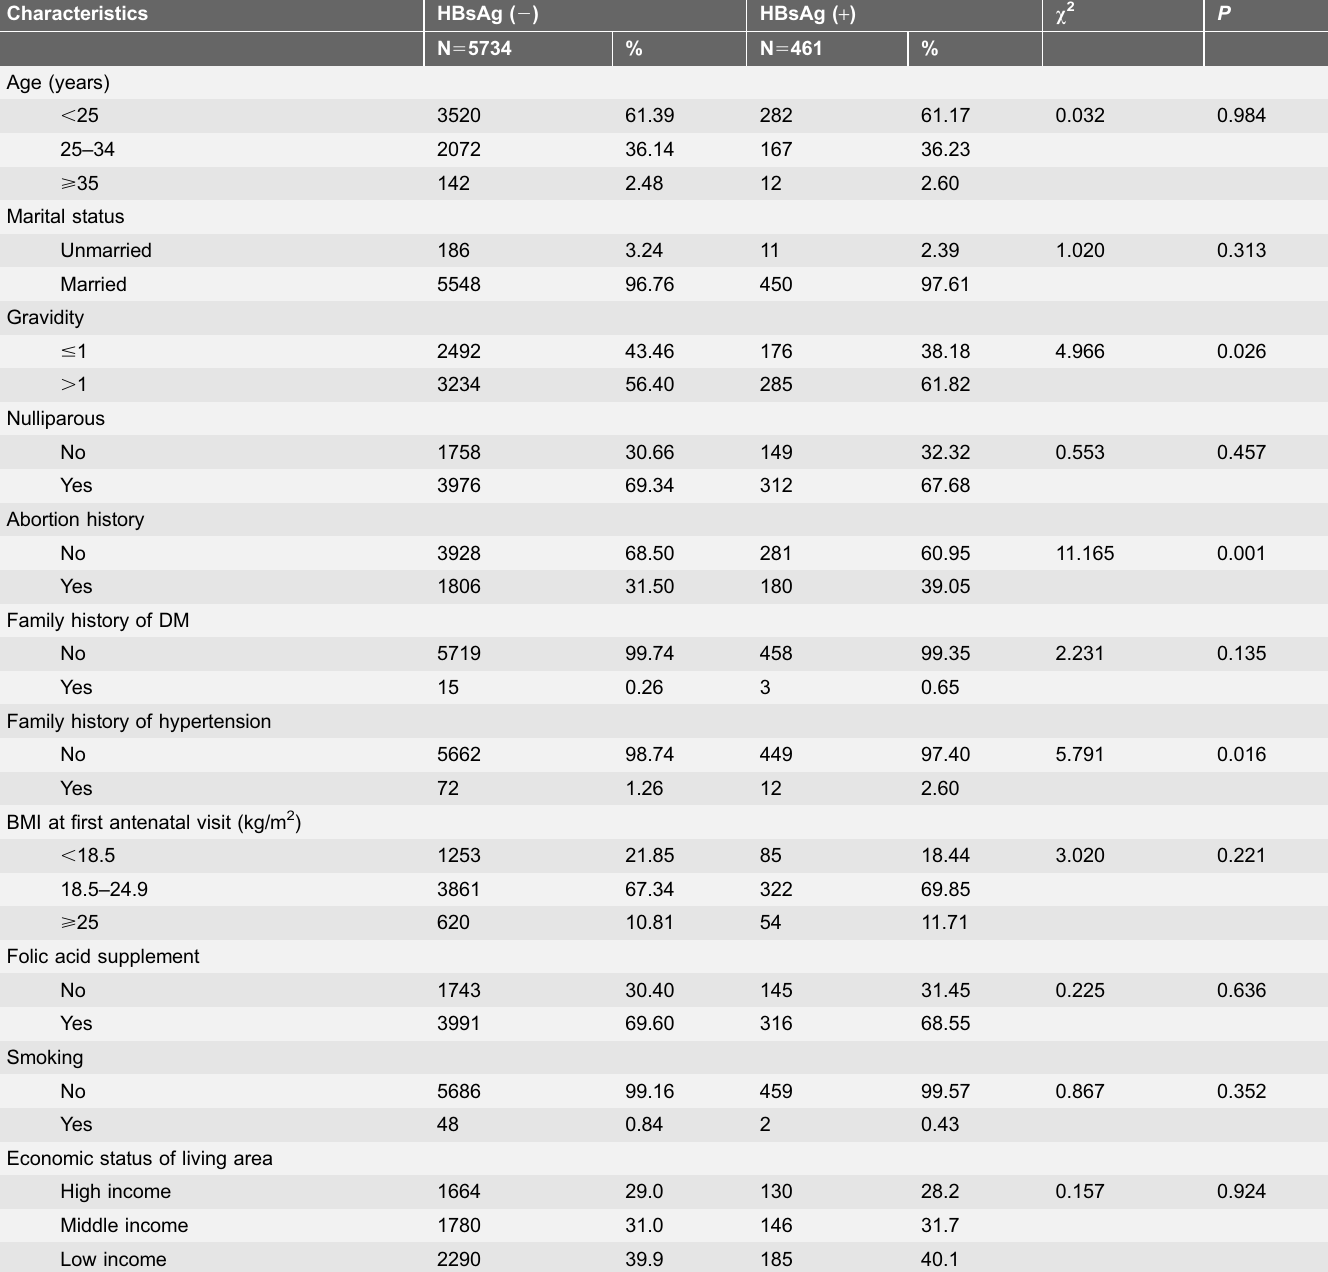
Table 1. Distribution of selected characteristics of subjects between maternal HBV carriers and non-HBV carriers, Liuyang, Hunan, China, 2012.